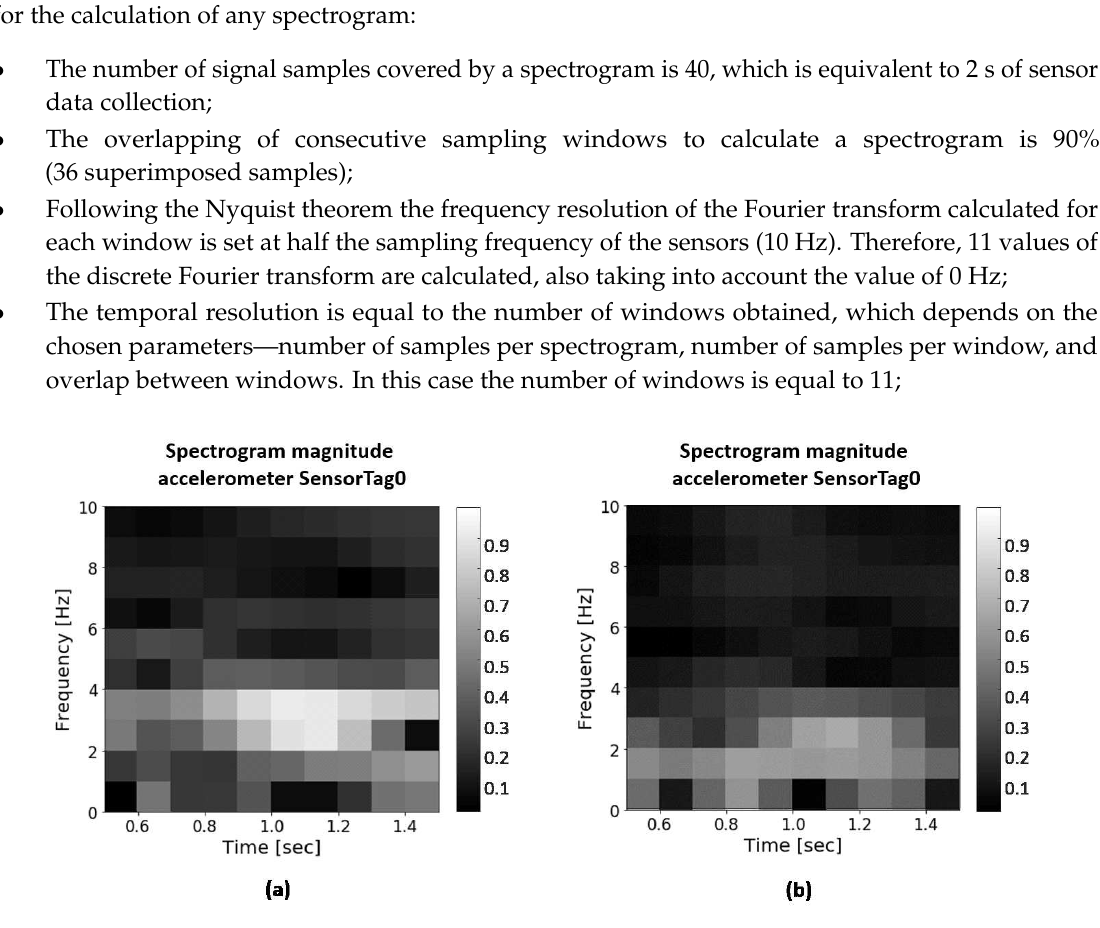
Figure 2. Spectrograms for running activity. ( a ) Male player. ( b ) Female